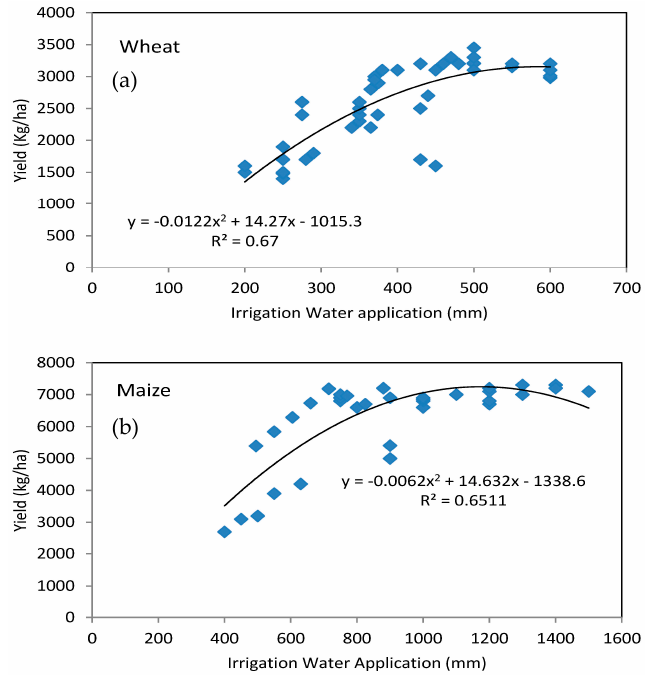
Figure 8. Relationship between crop water productivity and crop yield for wheat ( a ) and maize ( b ).